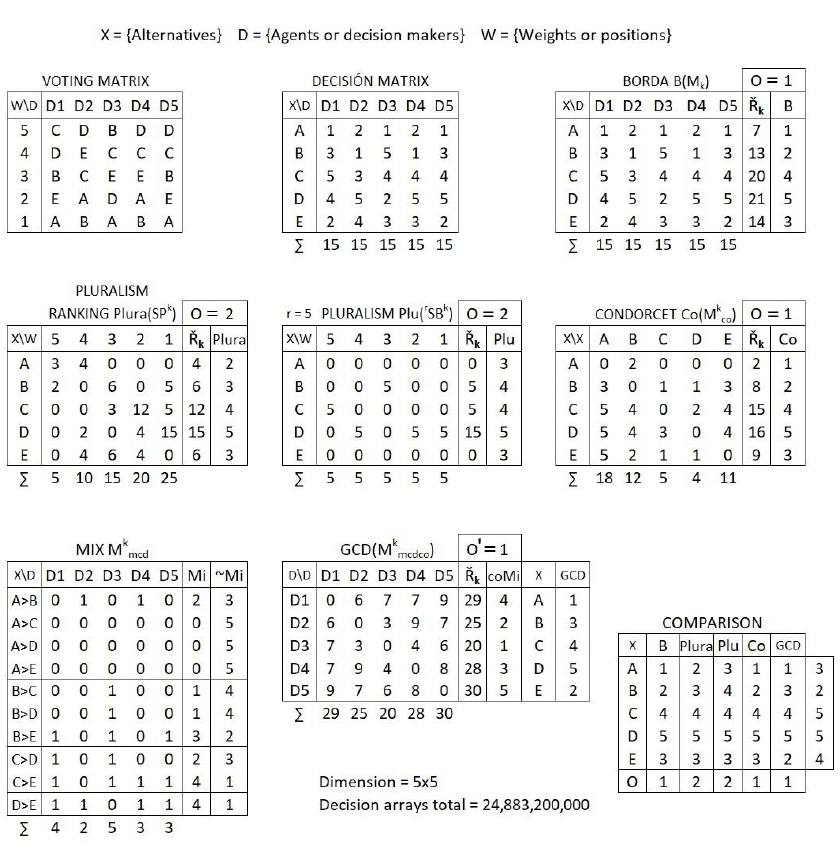
Figure 6. Comparison of the voting procedures, r SB k weight submatrix where “r = 5”.